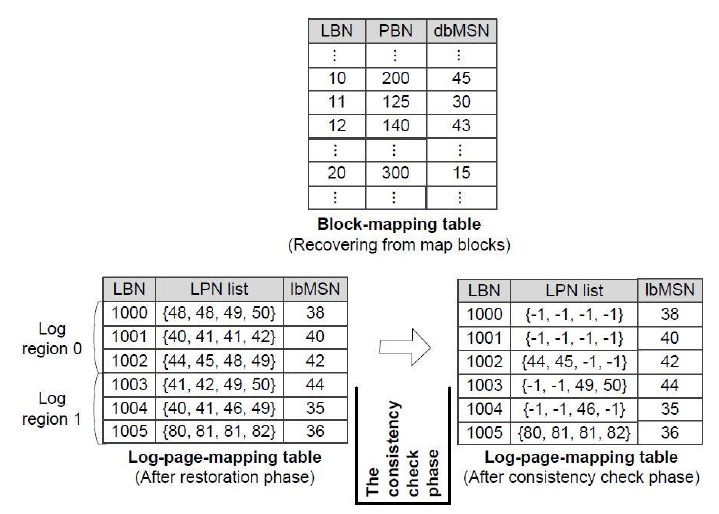
Figure 5. Consistency check phase.